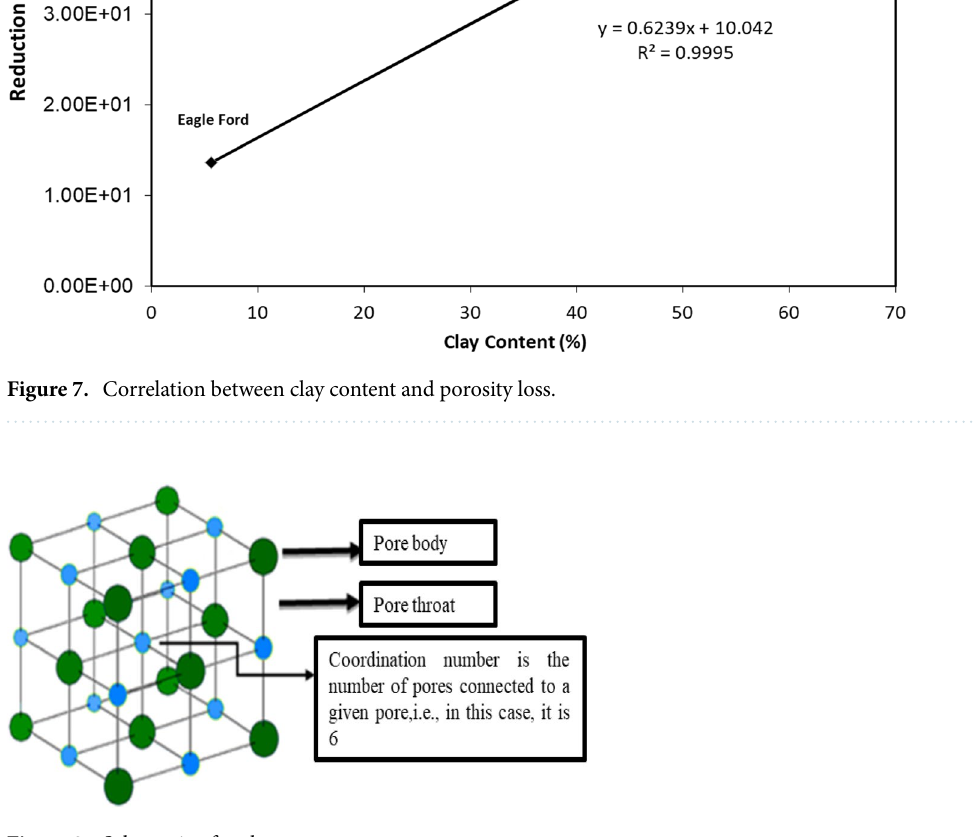
Figure 8. Schematic of each